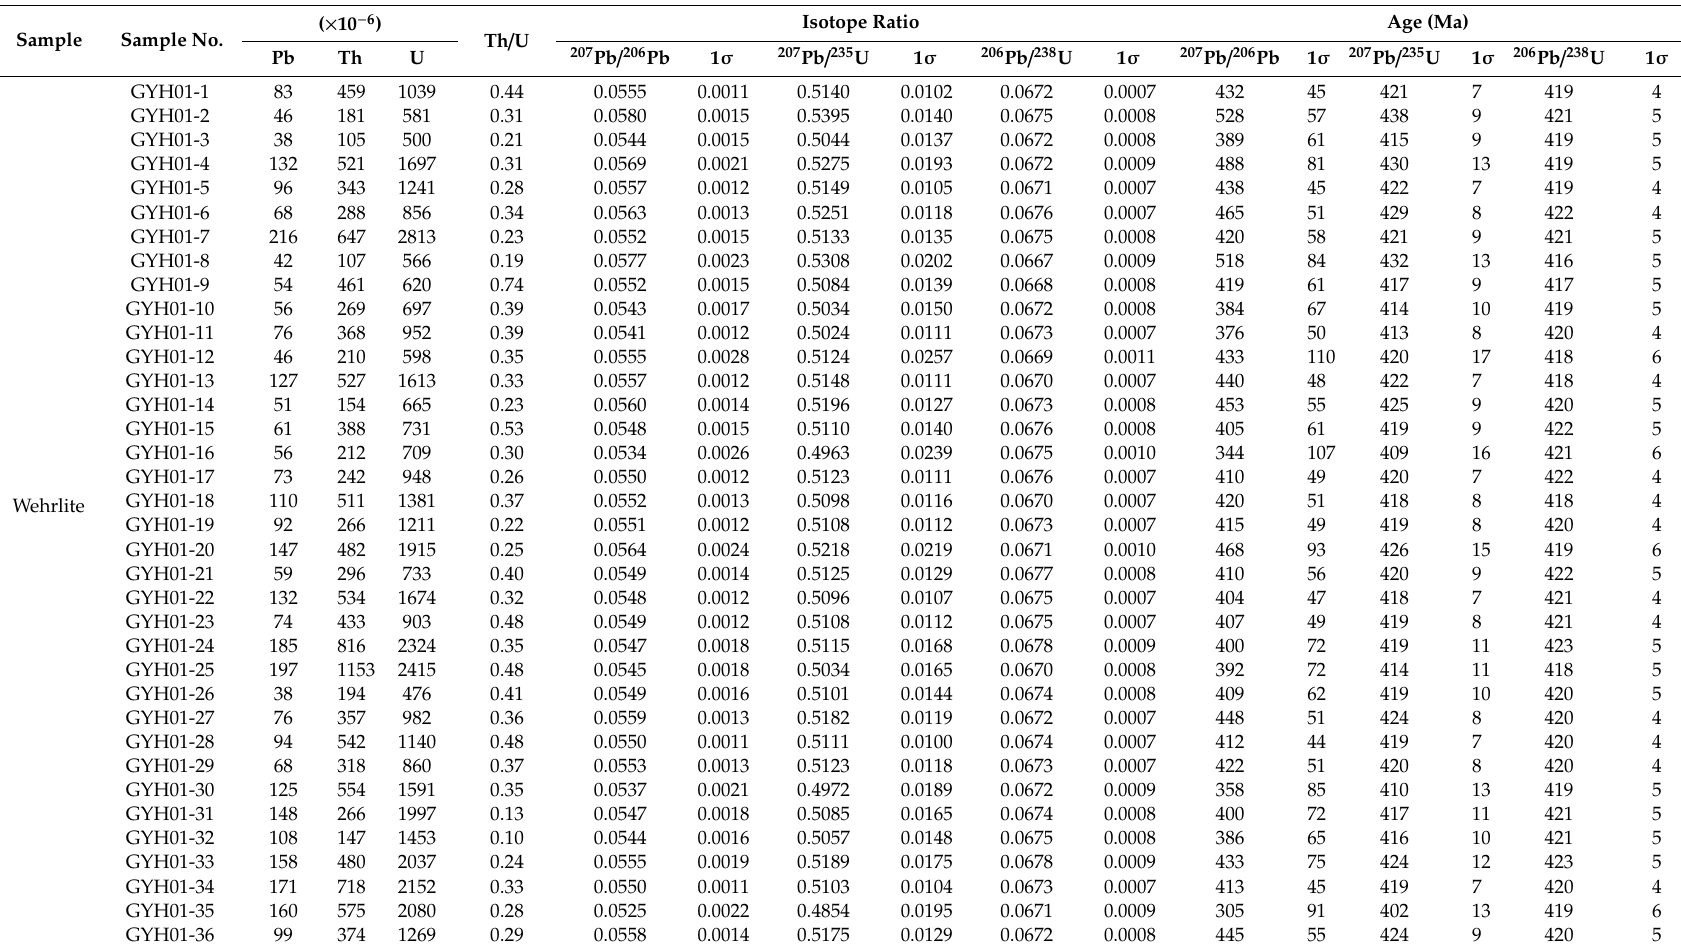
Table 1. LA-ICP-MS zircon U-Pb dating results of wehrlite and quartz